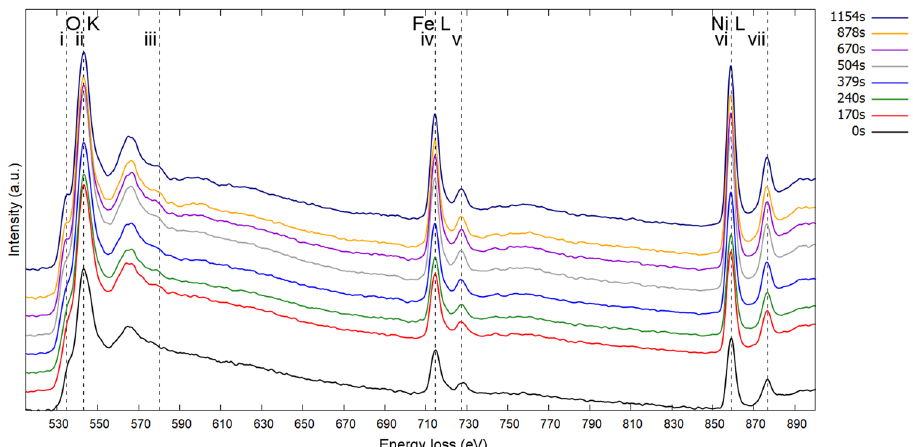
Fig. 4 Time series core loss EEL spectra of the oxygen K edge, iron L2,3 edge and nickel L2,3 ionization edges acquired at 300 kV. Each spectra is associated with the amount of time it is exposed to the electron